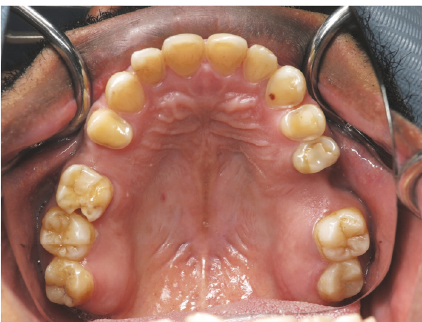
Figure 1: Dental erosions on the palatal surface of the maxillary anterior teeth and premolars.